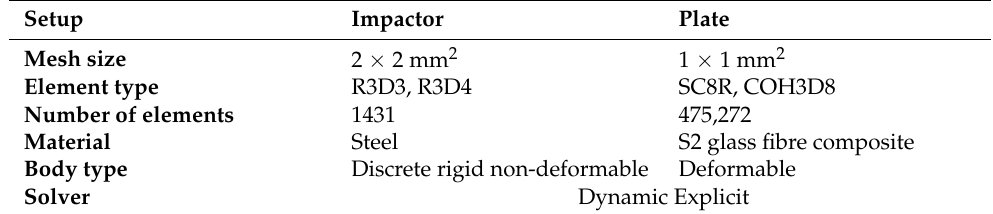
Table 7. FE model setup for impactor and